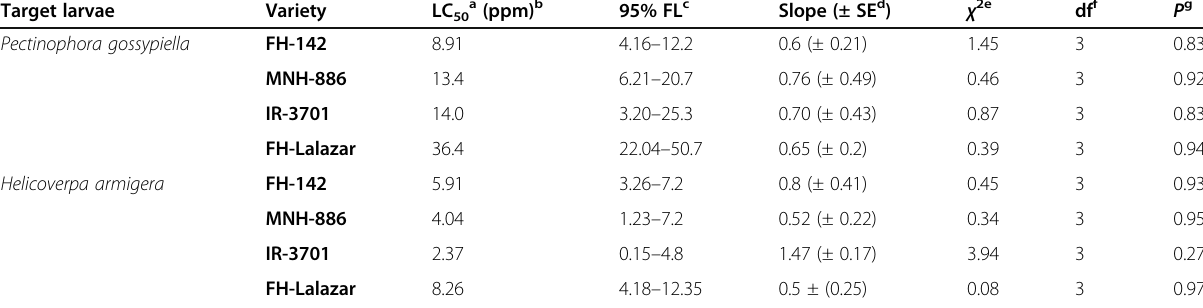
Table 1 Median lethal concentration of Bacillus thuringiensis protein against the target insect pest species Target larvae